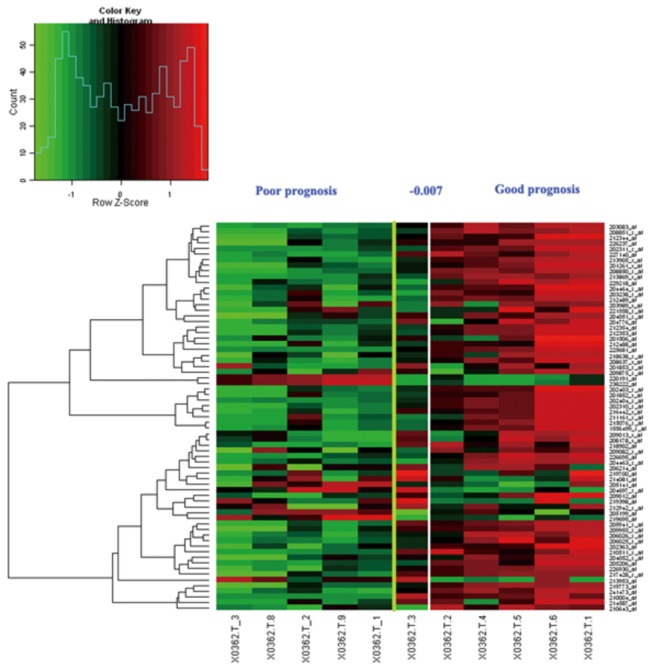
Expression data of final 74 custom microarray genes of the patients in previous study in the former data.The yellow line marks the subdivision into two dominant clusters by two-dimensional cluster analysis. The white line marks the subdivision into two dominant clusters with optimized sensitivity.